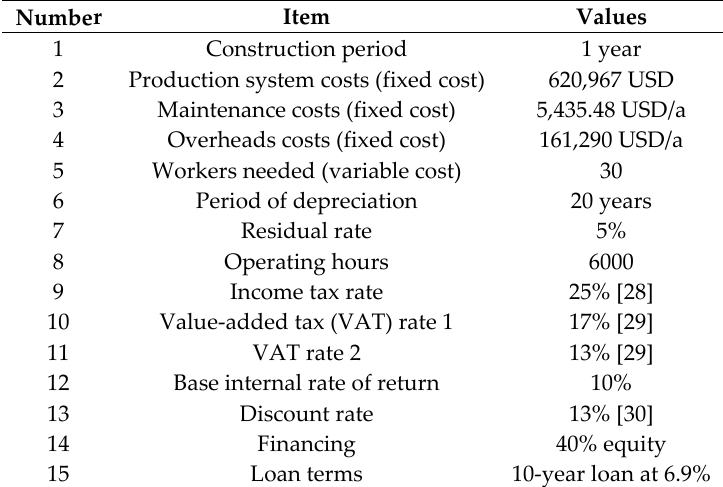
Table 5. The operating parameters of a BMF plant.